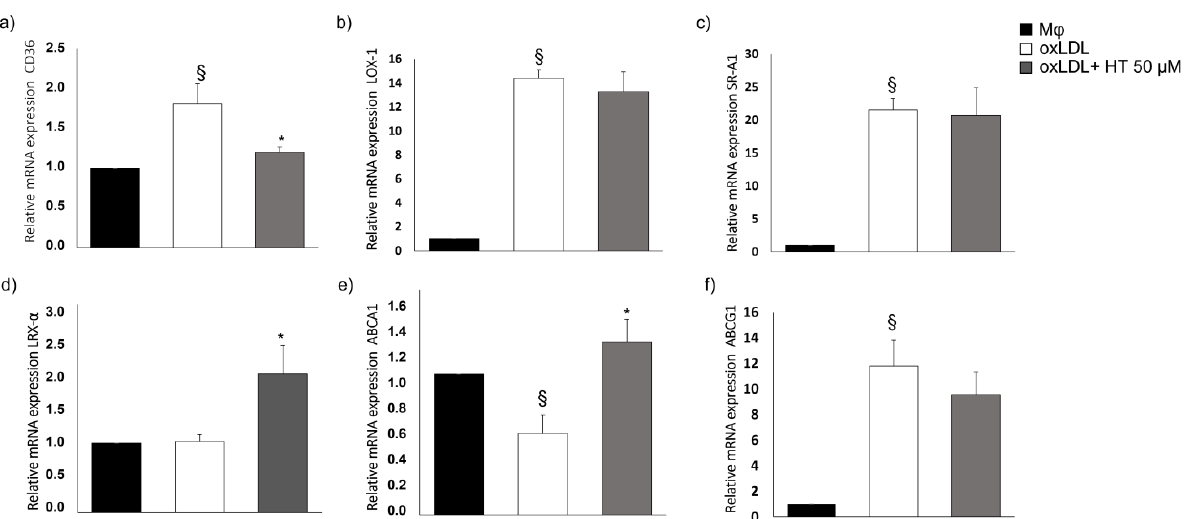
Figure 3. Effect of HT on expression of the major molecules responsible for cholesterol metabolism in foam cells: Gene expression levels of CD36 ( a ), LOX-1 ( b ), SR-A1 ( c ), LXRα ( d ), ABC transporters A1 ( e ) and G1 ( f ) were determined by quantitative RT-PCR in macrophages (M φ ) and foam cells w/o HT. § p < 0.001 vs. M φ ; * p < 0.005 vs. foam cells ( n = 6).